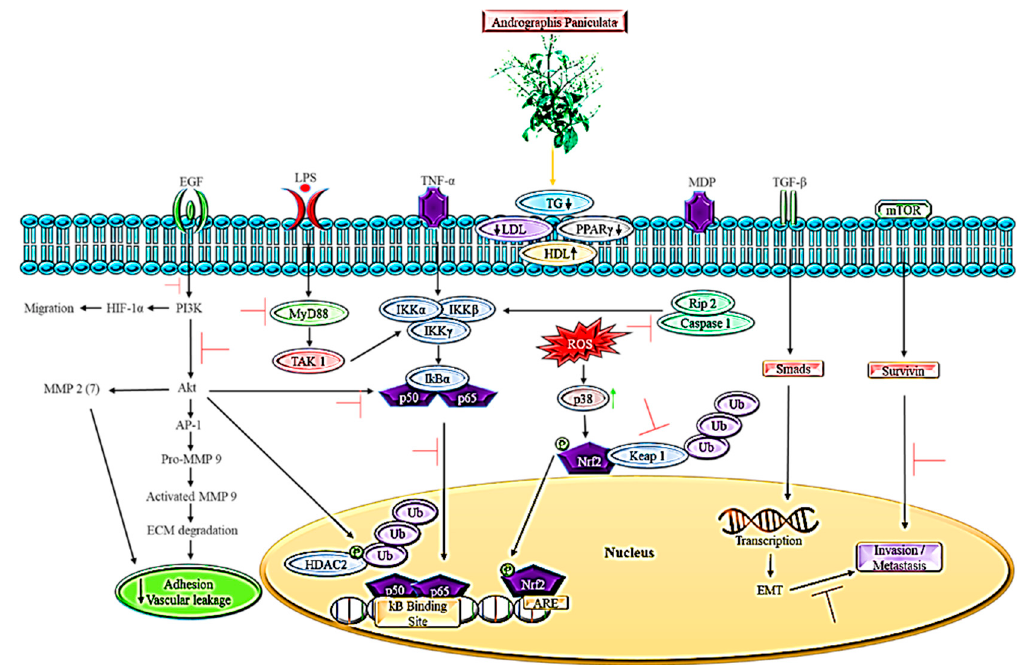
Figure 1. The possible mechanism used by A. paniculata in targeting lipid-mediated cancer path- ways.